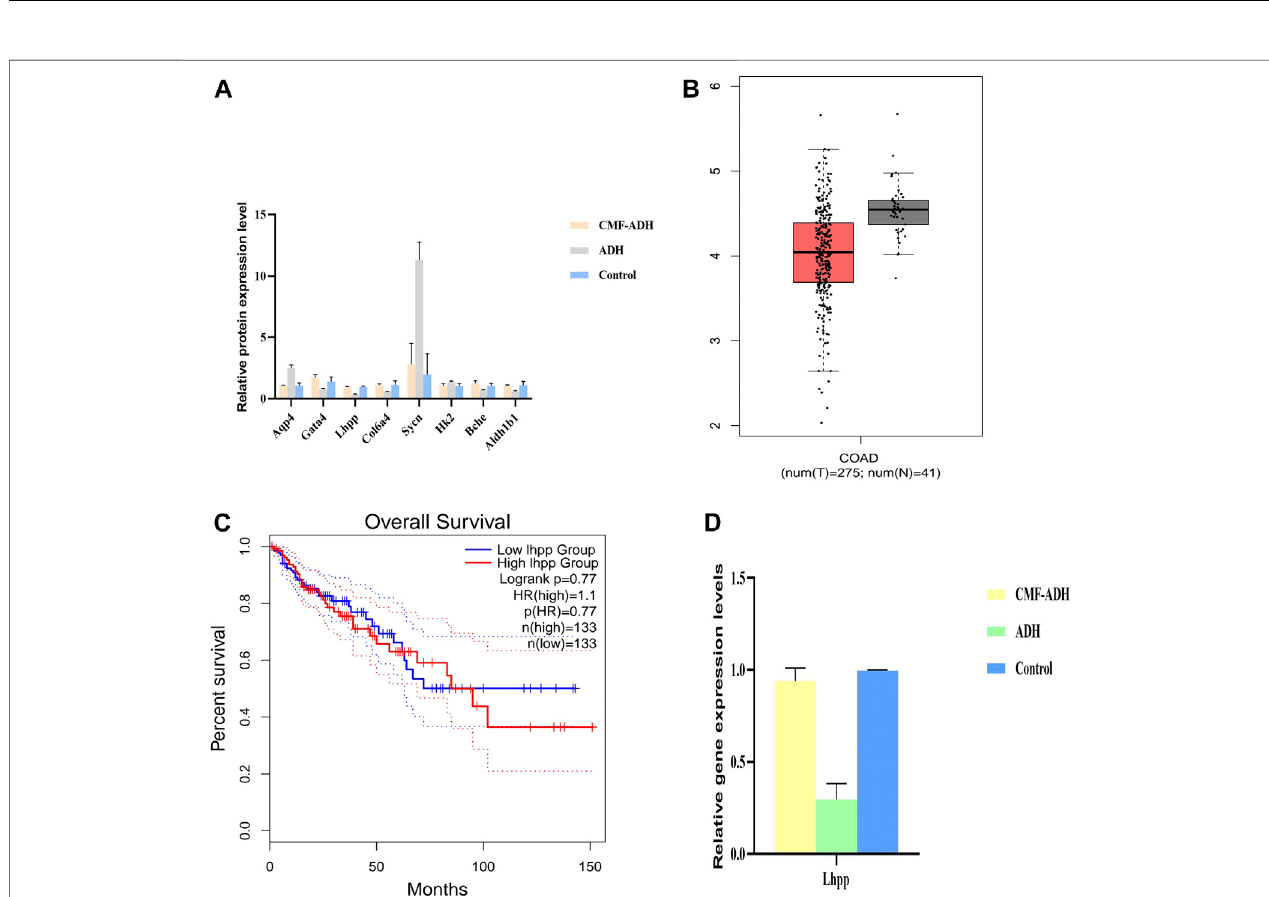
FIGURE 6 | Validation of the Transcriptome and proteome data in intestinal tissues (A) DEPs were selected and validated by PRM. Each data point is calculated from the average of biological triplicates. Results of the PRM analysis were consistent with TMT data. (B) Decreased expression of LHPP in colorectal cancer tissues when compared with normal tissues from the TCGA database (C) No signi fi cant difference in overall survival was observed between patients from the TCGA database with high LHPP expression. **** p < 0.0001 (D) . Comparison of relative gene expression level of the selected differentially regulated proteins measured by qPCR. Each data point is calculated from the average of biological